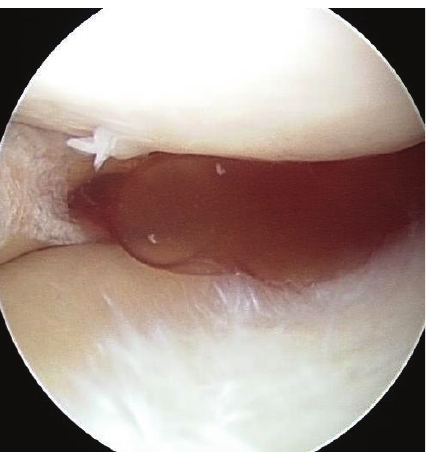
Figure 4: Arthroscopy revealed a meniscal cyst that was decom- pressed under direct